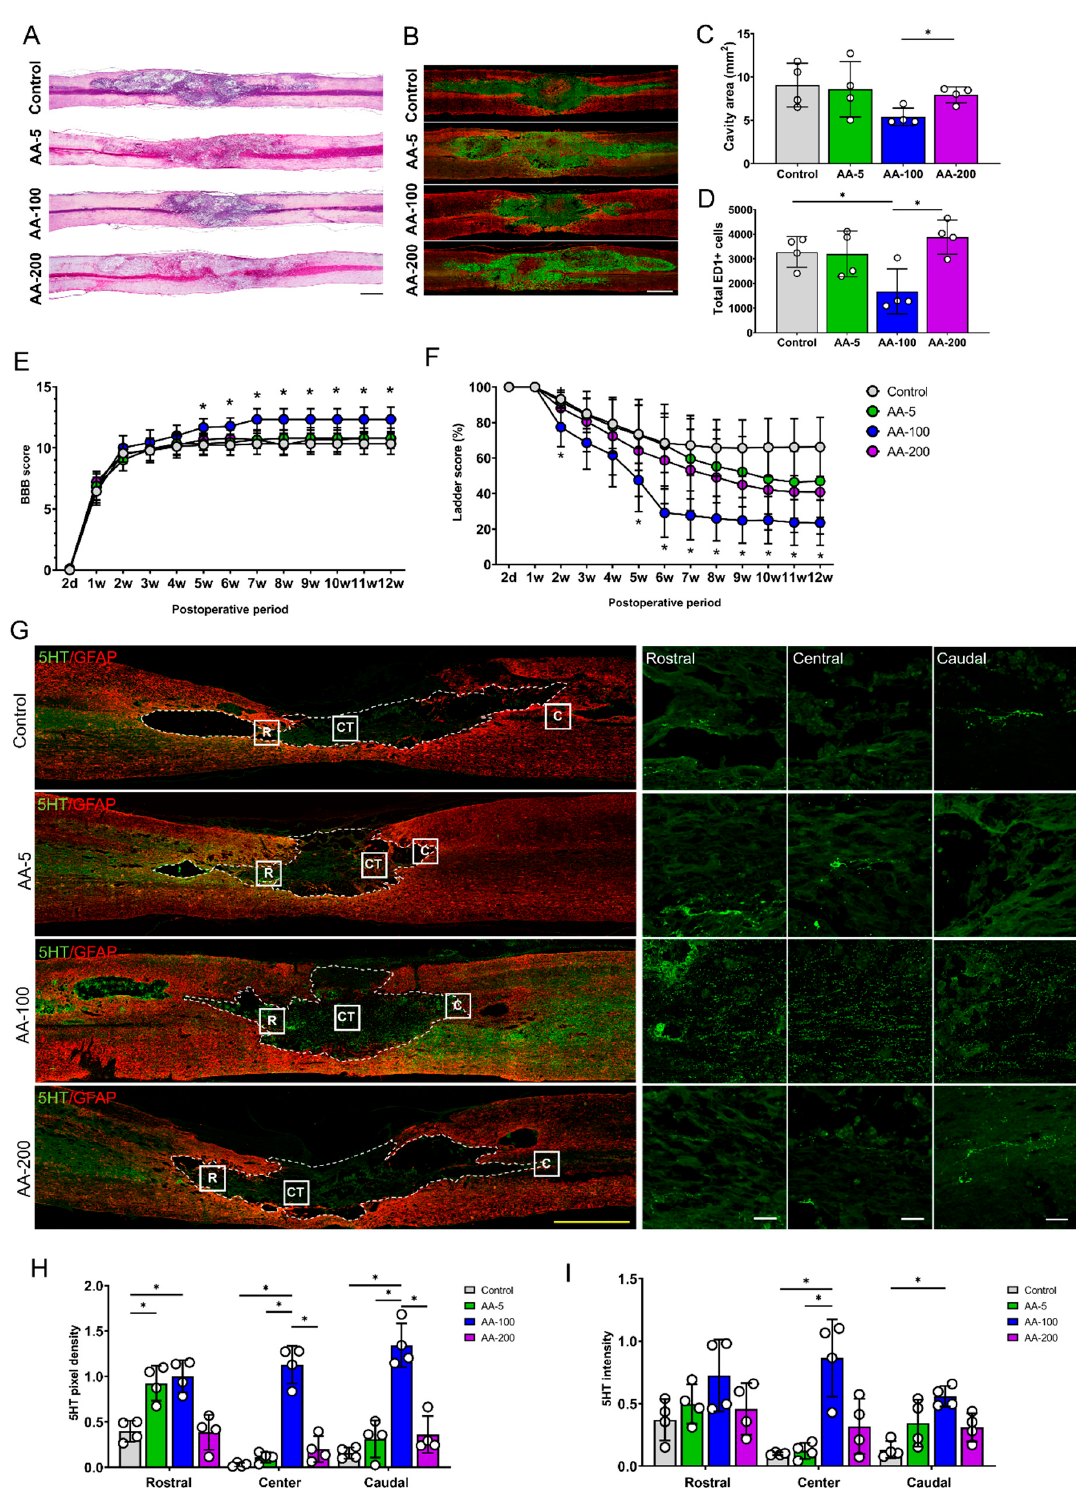
Figure 3. Histological and functional changes after application of ascorbic acid (AA) at concentrations of 5, 100, and 200 mg/kg to SCI models. ( A , B ) Representative images of hematoxylin and eosin (H&E) staining ( A ) and immunohistochemical images of ED1 (green) and GFAP (red) ( B ) in contused spinal cords in the control group and the 5, 100, and 200 mg/kg AA-treated SCI groups (the AA-5, AA-100, and AA-200 group, respectively) at 1 week after injury. ( C , D ) Sizes of the lesion cavities (mm 2 ) from the H&E staining results ( C ) and the total numbers of ED1-positive cells within sagittal sections from immunohistochemical images ( D ) for the control, AA-5, AA-100, and AA-200 groups ( n = 4 per